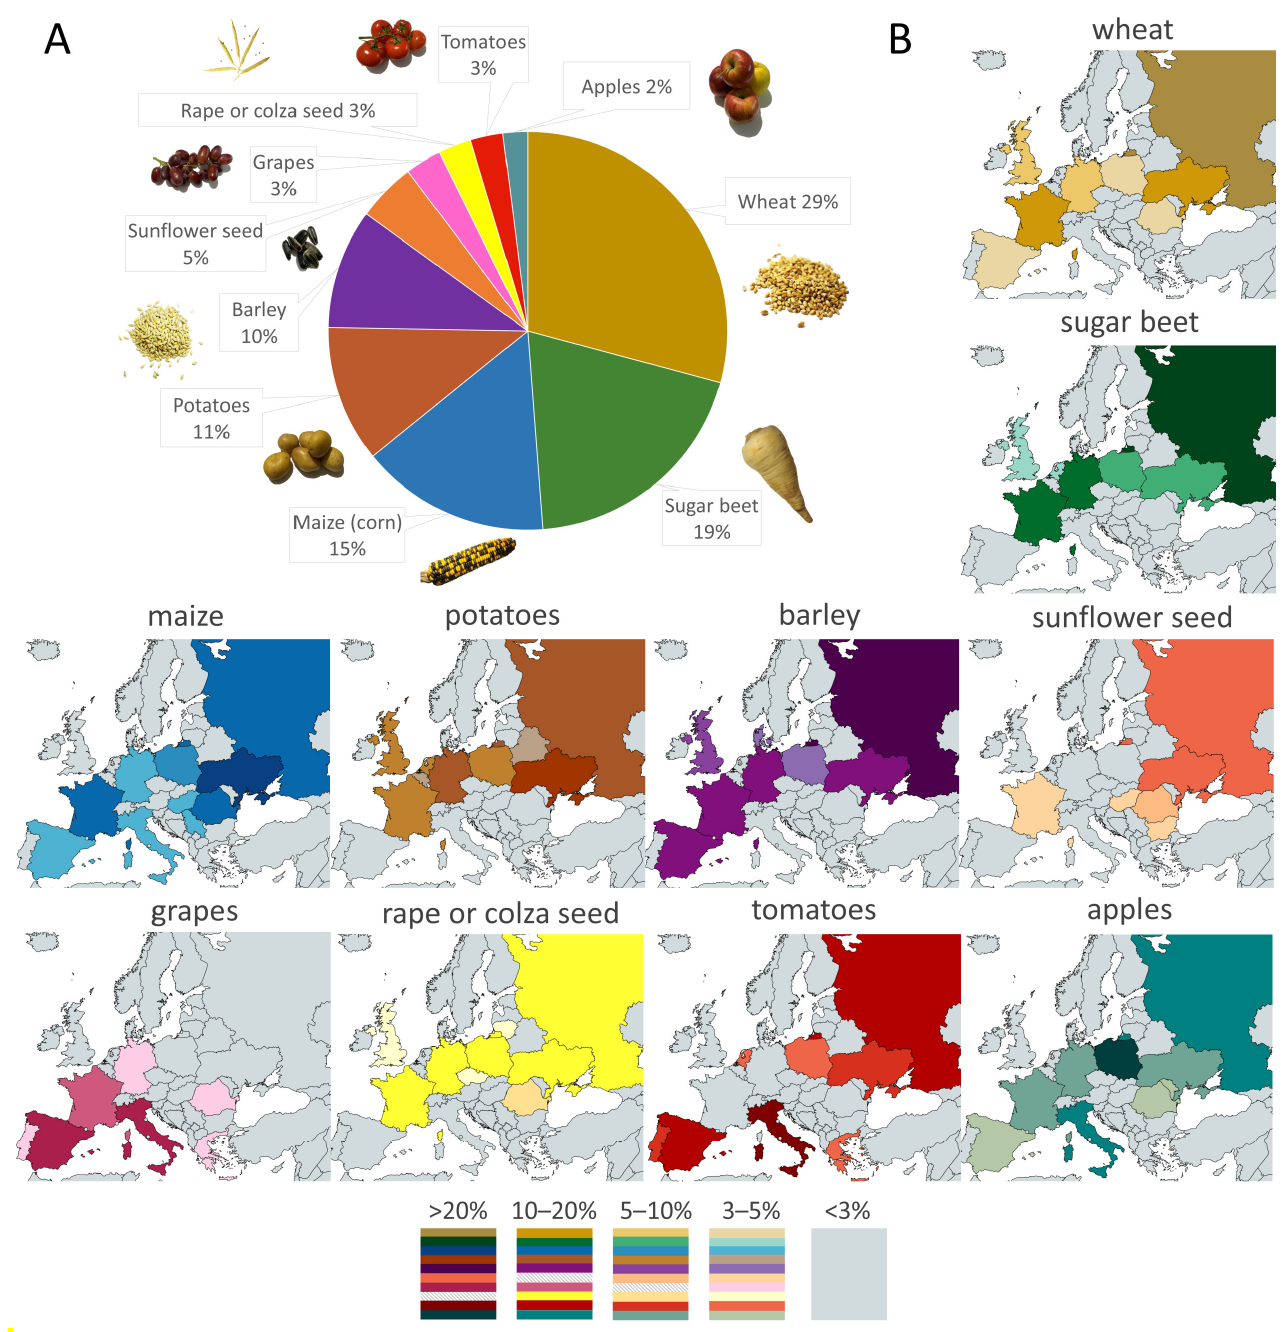
Figure 2. The most important crops produced in Europe in 2021. Data were obtained from FAOSTAT [8]. ( A ) The pie chart represents the percentage of various crops under production in Europe in 2021. ( B ) The main countries in Europe that produce the selected crops. The color intensity corresponds to the contribution of individual states to overall production in Europe. The color coding in the legend was sorted from top to bottom according to the amount of production of individual crops. Hatched rectangles in the color legend indicate crop production not used in the figure. Panel 2B was prepared using maps from www.mapchart.net (accessed on 17 January 2023), distributed under a CC SA 4.0